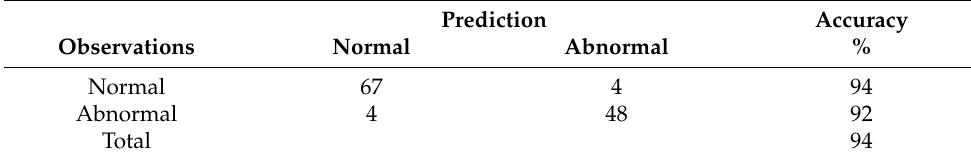
Table 4. Confusion matrix of the proposed